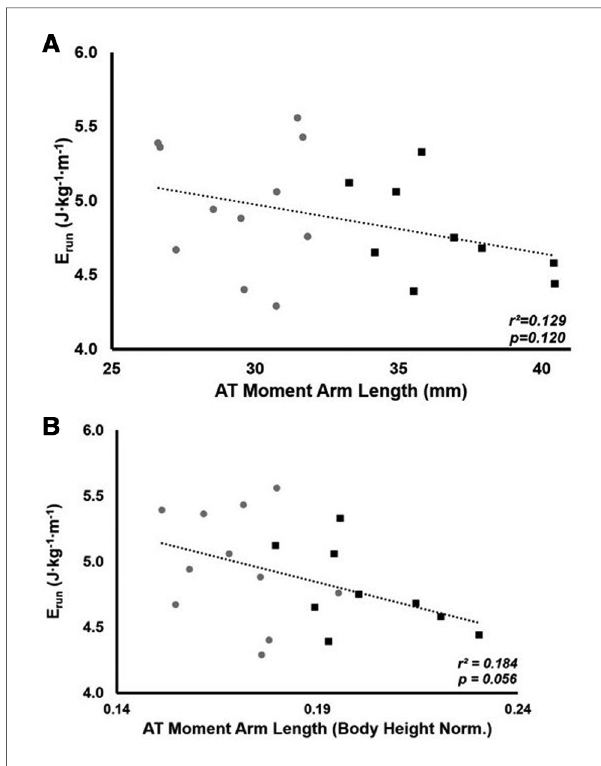
FIGURE 1 The relationship between the energy cost of running (E run ) and AT MA ( A ) and the relationship between E run and height normalized AT MA ( B ). Grey circles represent the SHORT AT MA group, while black squares represent the LONG AT MA group.